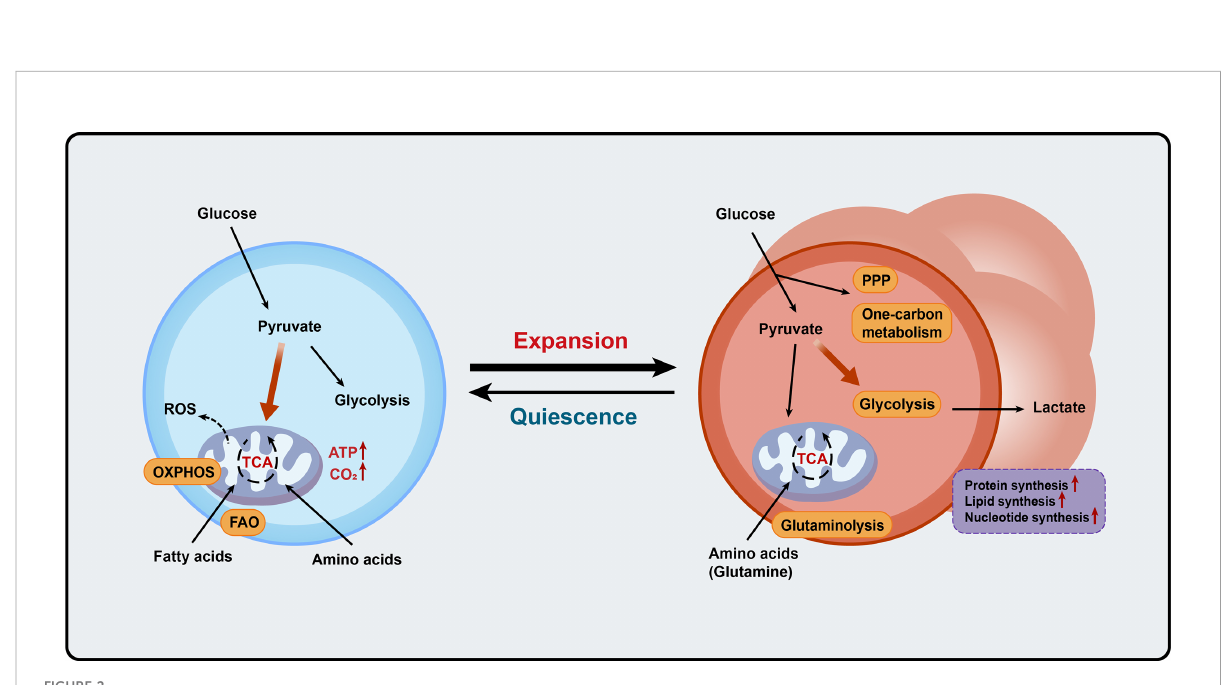
FIGURE 2 Metabolic programs match expansion demands of thymocytes. Blue cells on the left represent the quiescent thymocytes, and red cells on the right represent proliferative thymocytes. OXPHOS, oxidative phosphorylation; FAO, fatty acid oxidation; ROS, reactive oxygen species; ATP, adenosine triphosphate; PPP, pentose phosphate pathway; TCA, the tricarboxylic